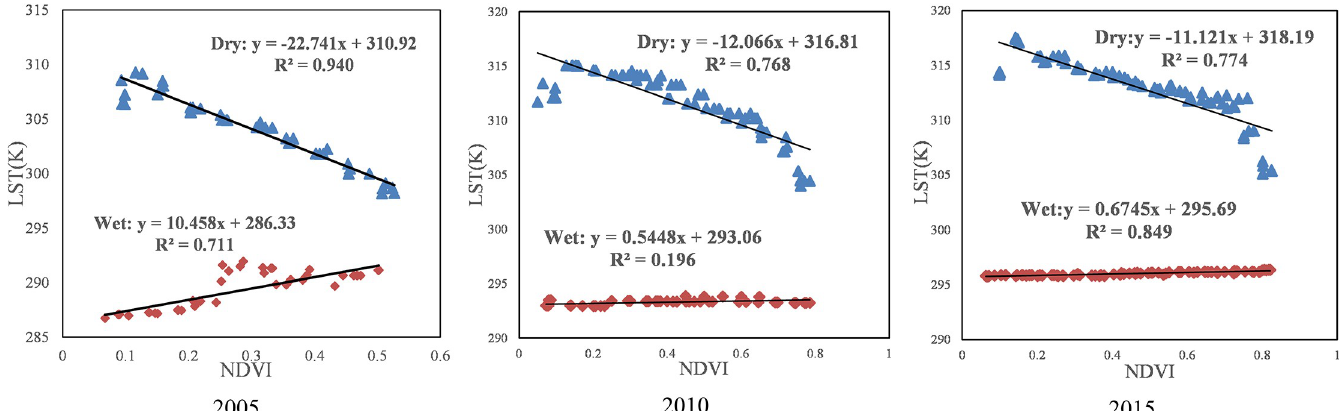
Fig 4. Fitting results for LST and NDVI for the Xiongan New Area in 2005, 2010 and 2015.